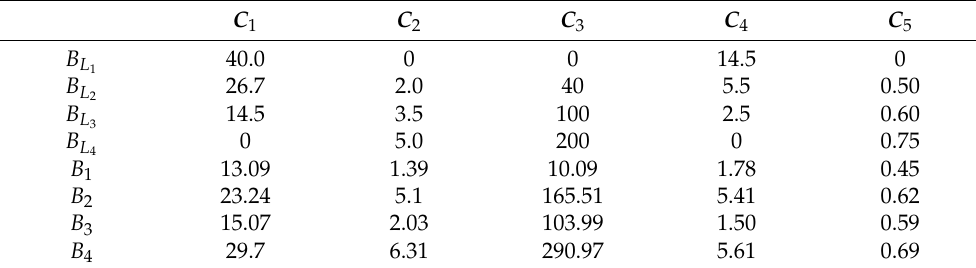
Table 2. Initial indicator